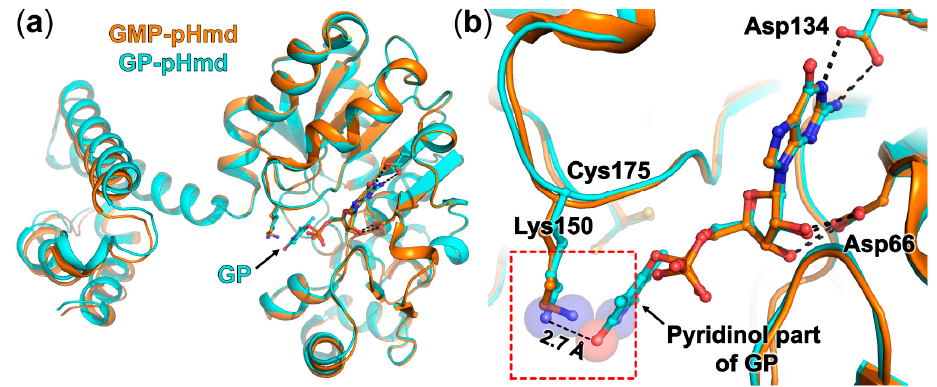
Figure 4. Structural comparison of the GMP-bound form (orange) and the GP-bound form (cyan) of pHmd. ( a ) Monomers of each structure are shown by a cartoon model. The N-terminal domains are superposed. ( b ) Zoomed-in view of the active site. GMP and GP are shown by ball and stick models. Hydrogen bonds are indicated by dashed lines.